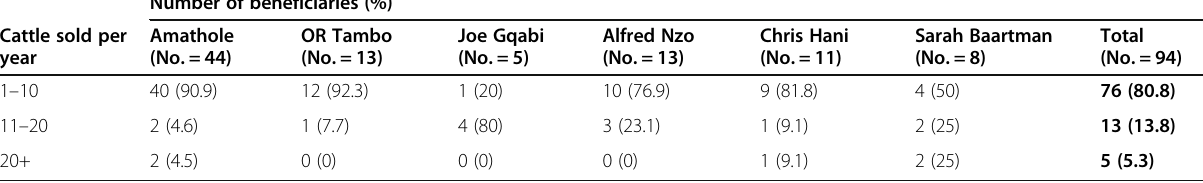
Table 6 Cattle sold by beneficiaries (farmers) per year across six districts (No. = 94) Number of beneficiaries (%) Cattle sold per year